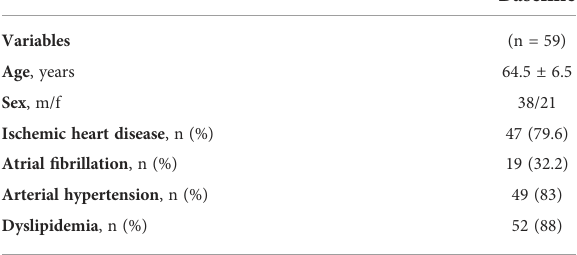
TABLE 1 Baseline characteristics and comorbidities of enrolled patients.